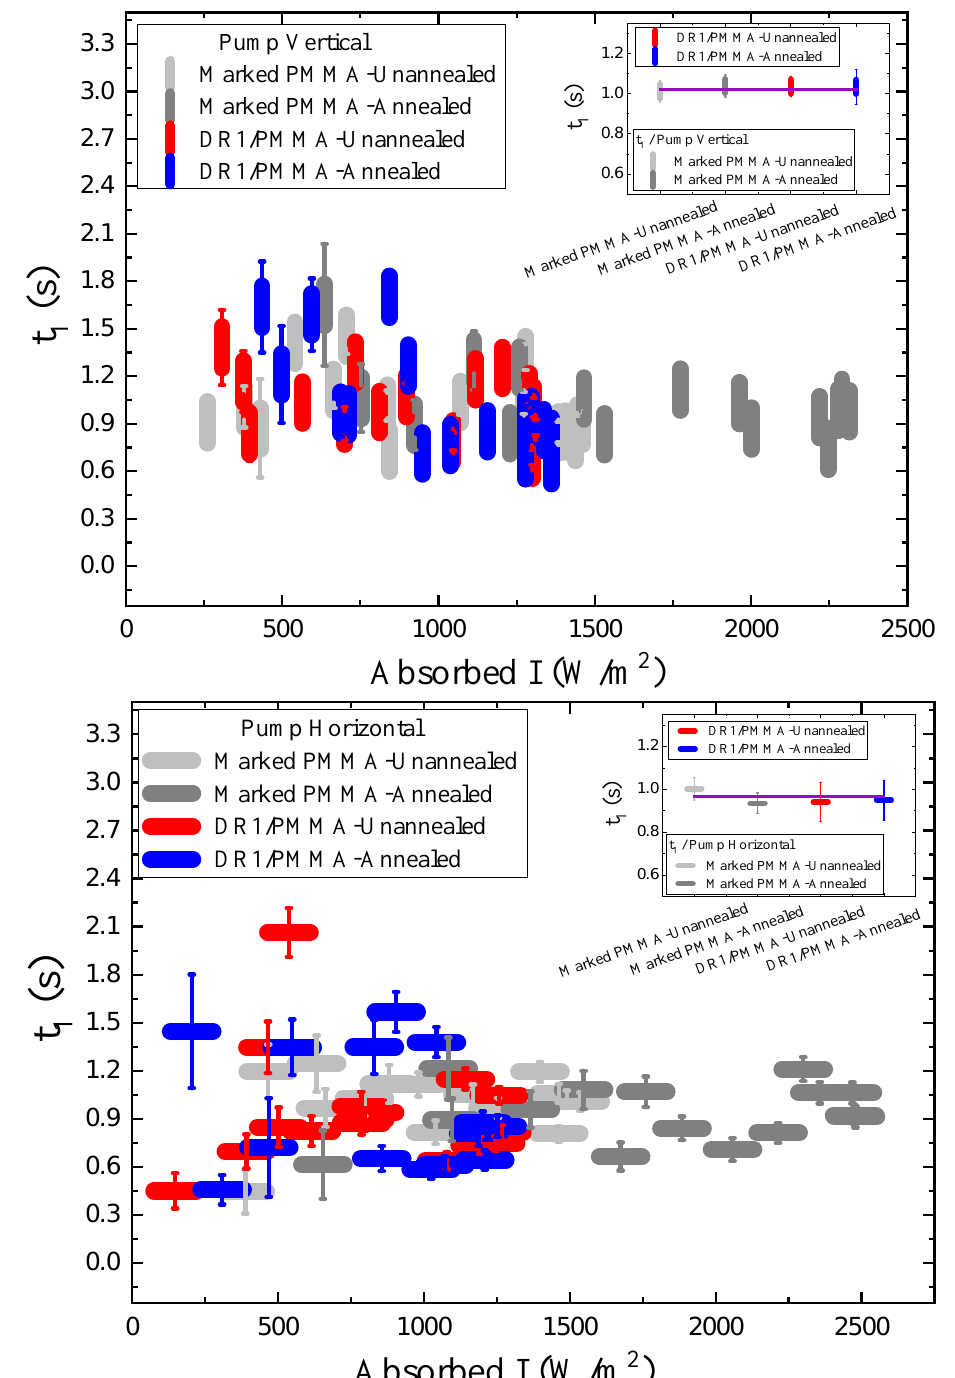
Figure 16. Time constant t 1 —light on—as a function of absorbed intensity for unannealed and annealed PMMA and DR1/PMMA fibers for vertical and horizontal pump polarization. The insets show the average time constants over all intensities as a function of the fiber’s composition. The “marked” samples are those whose surfaces are painted black to prevent light from entering that sample, resulting in surface heating